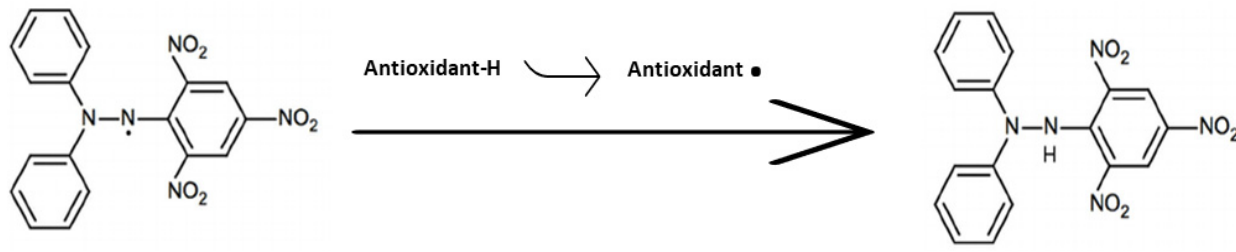
Figure 3. Reaction mechanism of 2,2-diphenyl-1-picrylhydrazyl (DPPH) with antioxidant.